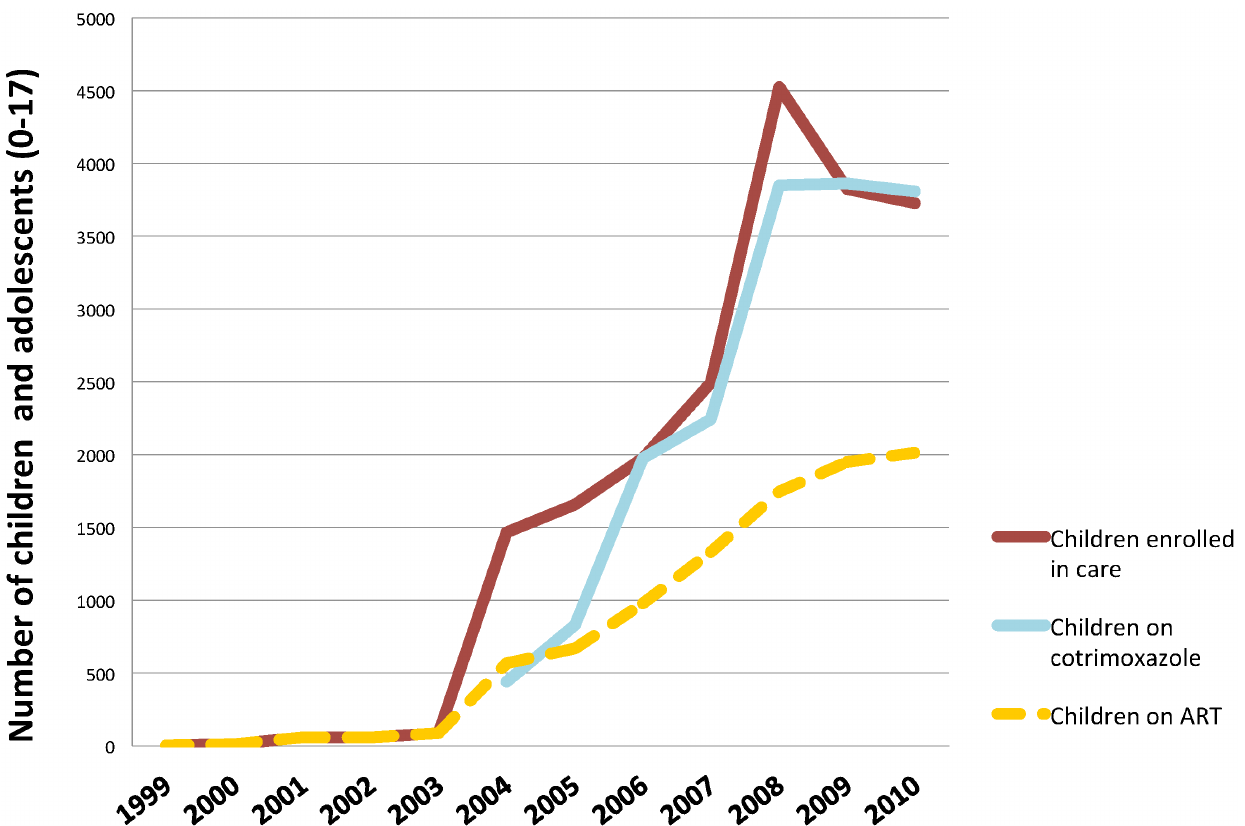
Figure 2. Cumulative trend of uptake of paediatric care after introduction of family-based approach at Mildmay main site in 2003. Figure demonstrates uptake trends from 1999 to 2010 for three key indicators: number of children and adolescents enrolled in HIV care, number on cotrimoxazole prophylaxis, and number on ART. Uptake data shows sharp increases for all three indicators at 2003, when the family-based approached was introduced at Mildmay.